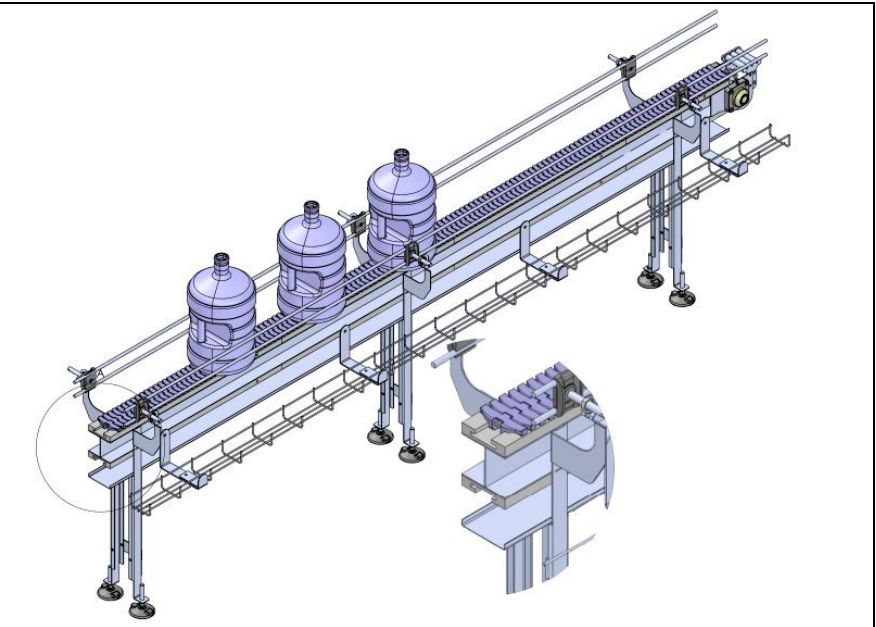
Figure 10. Concept 3—Conveyor with an I-beam substructure.